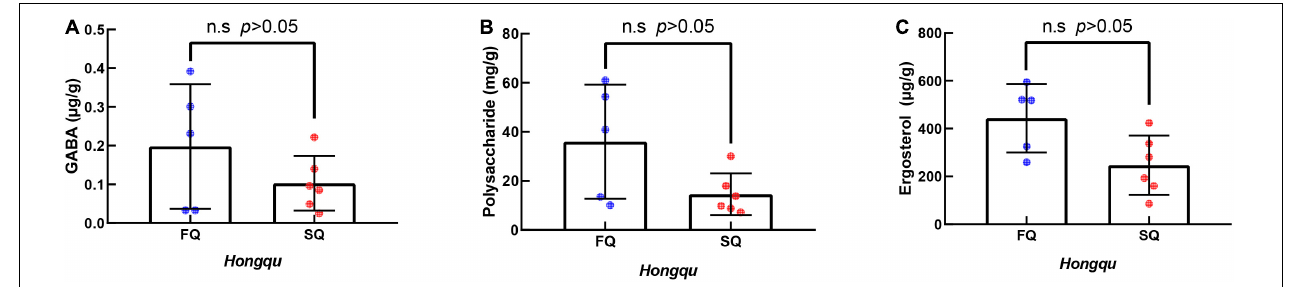
FIGURE 3 | The γ -aminobutyric acid (GABA), polysaccharides, and ergosterol of functional Qu (FQ) and coloring Qu (CQ), respectively. (A) The γ -aminobutyric acid. (B) Polysaccharides. (C) Ergosterol.